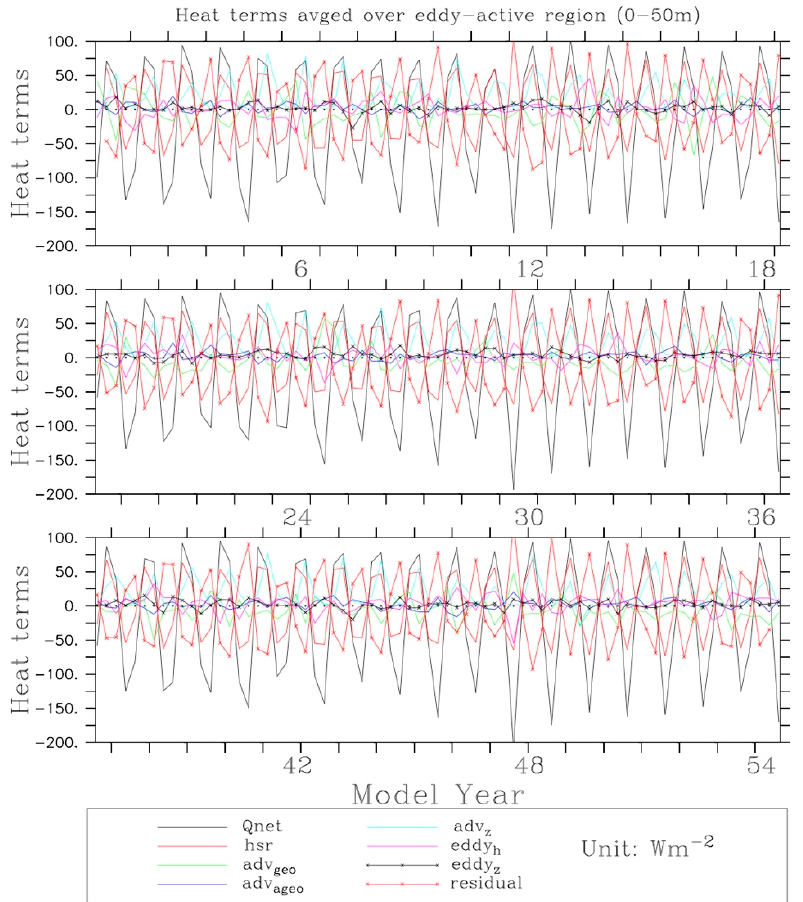
Figure 10. Heat budget analysis for the upper 50 m ocean. Time series of the net surface heat flux (Qnet, in black), rate of heat storage (hsr, in red), horizontal heat advection caused by geostrophic current (adv geo , in green), horizontal heat advection caused by ageostrophic current (adv ageo , in blue), vertical heat advection (adv z , in cyan), horizontal eddy heat flux convergence (eddy h , in magenta), vertical eddy heat flux convergence (eddy z , in black-cross), and a residual term (in red-cross) area- averaged over an eddy-rich region. Unit: W m − 2 .